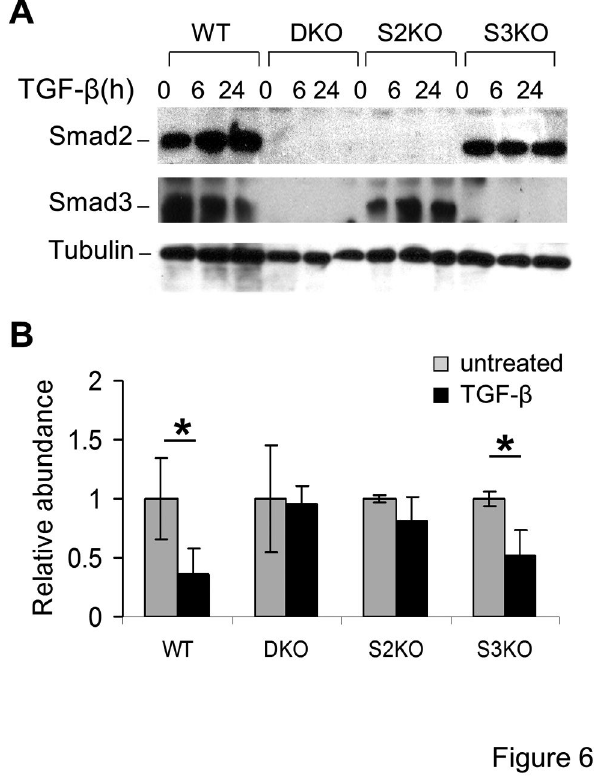
Figure 6. The Smad2-dependent pathway mediates the TGF-β-induced downregulation of miR-30d, and Smad3 is not required. A . Immunoblots depicting total Smad2 or total Smad3 protein levels in wildtype (WT), Smad2-deficient (S2KO), Smad3-deficient (S3KO), or Smad2/Smad3-double deficient (DKO) conditionally immortalized murine podocytes at baseline (0 hr) or treated with TGF-β (5 ng/ml) for 6 and 24 hr (tubulin is shown as loading control). B . Bar graph showing the mean ± S.D. of the relative abundance of miR-30d after 24 hr of TGF-β treatment (black bars) normalized to untreated conditions in WT, S2KO, S3KO, or DKO podocytes. * denotes p < 0.05.